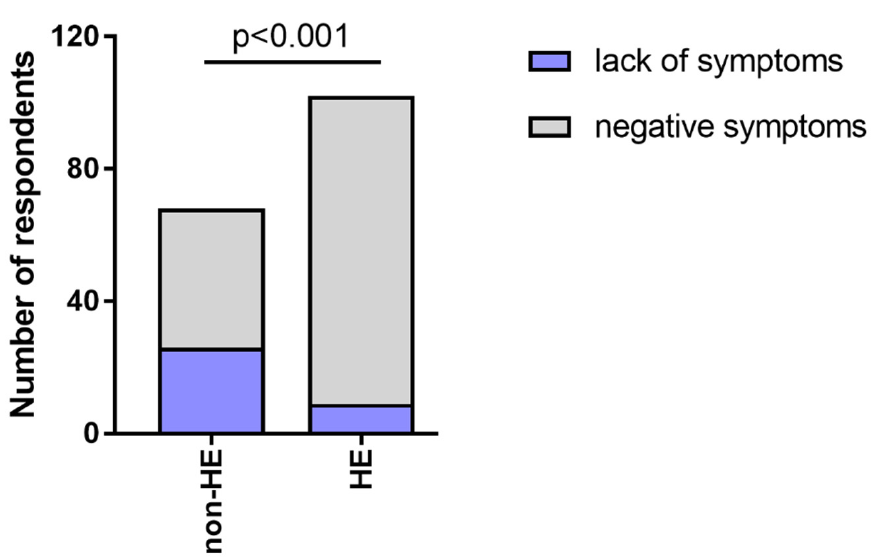
Figure 8. Negative effects and lack of negative effects during the application of the antiseptic experienced in both groups (HE-study group vs non-HE). 86.27% of the subjects from the HE-study group (n = 88/102) reported pain and burning sensations after using disinfectants, while in the non-HE group, it was reported by 42.65% (n = 29/68) (Figure 9).